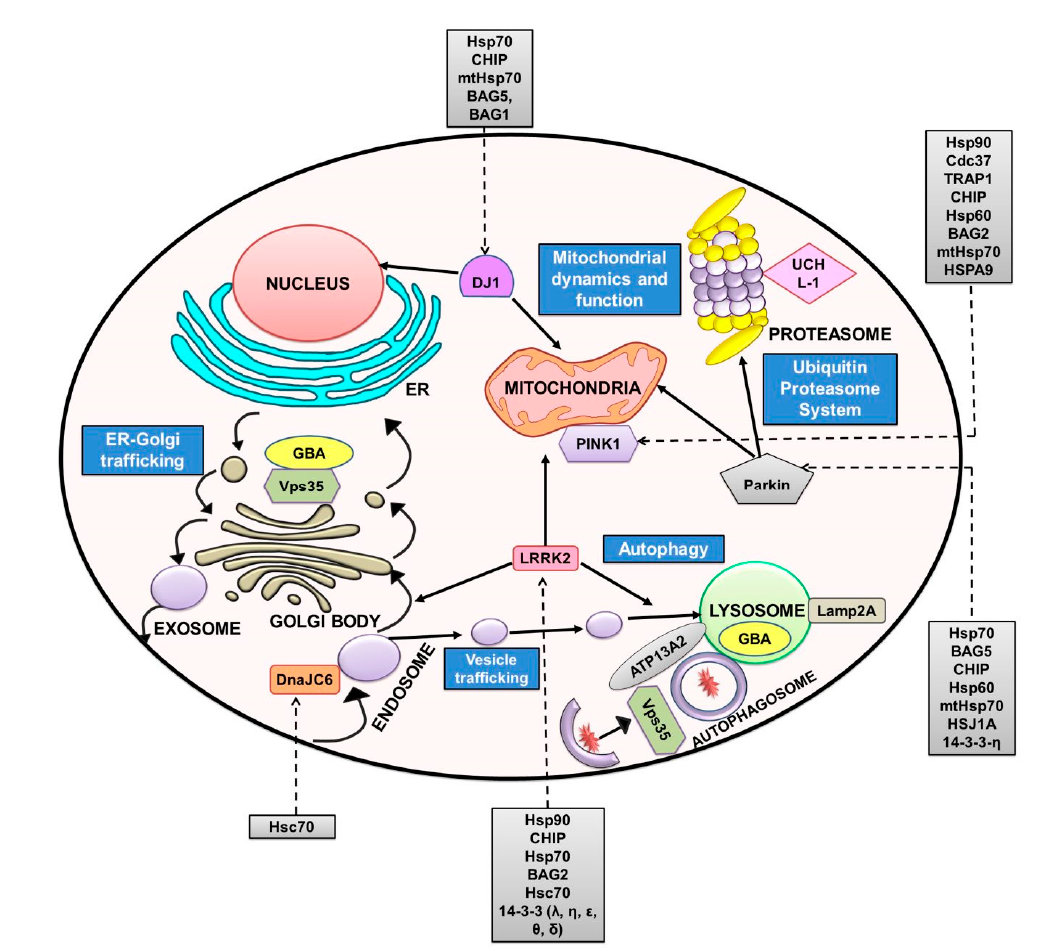
Figure 3. PD-related proteins and chaperones involved in proteostasis: Other well-characterized PD-related proteins, their cellular localization and functional pathways involved are depicted in this figure. These include leucine-rich repeat kinase 2 (LRRK2; PARK8), PTEN-induced putative kinase 1 (PINK1; PARK6), Parkin (PARK2), DJ-1 (PARK7), glucocerebrosidase (GBA), Vps35, UCH-L1 and ATP13A2. A role for LRRK2 in vesicular tra ffi cking, mitochondrial dynamics and lysosome-autophagy pathways has been reported [206]. Mutations in LRRK2 associated with PD and perturb functions related to above cellular pathways are identified. PINK1 / Parkin-mediated mitophagy has been extensively characterized, and mutations in these proteins are associated with PD. Parkin also induces protein degradation via UPS [207]. DJ-1 regulates mitochondrial function during oxidative stress and is also reported to localize to the nucleus [155,156]. Vps35 is a component of the retromer complex and has a role in endosomal tra ffi cking and autophagy-mediated degradation [208]. GBA is an active lysosomal enzyme involved in the degradation of complex molecules and mutations in GBA are likely to accumulate toxic α -synuclein aggregates [208]. Another important protein is associated with lysosomal dysfunction, and therefore, cell viability is ATP13A2. Mutations in this protein are identified in PD patients [4]. Ubiquitin C-terminal Hydrolase L1 (UCH-L1) is involved in the UPS pathway of proteostasis, and mutations in this protein leading to PD pathogenesis have been identified [66]. Several DNAJ proteins that belong to the Hsp40 family are studied for their role in PD. Mutations in one of these chaperones, DNAJC6, resulted in the onset of juvenile PD [177]. Most of these proteins interact with chaperones to maintain their cellular homeostasis and.